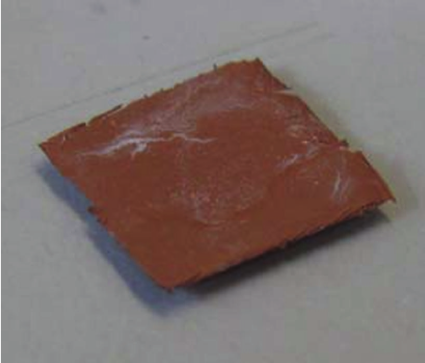
Figure 1: Thin foil of Copper-CNT composite prepared by elec- trodeposition [34].